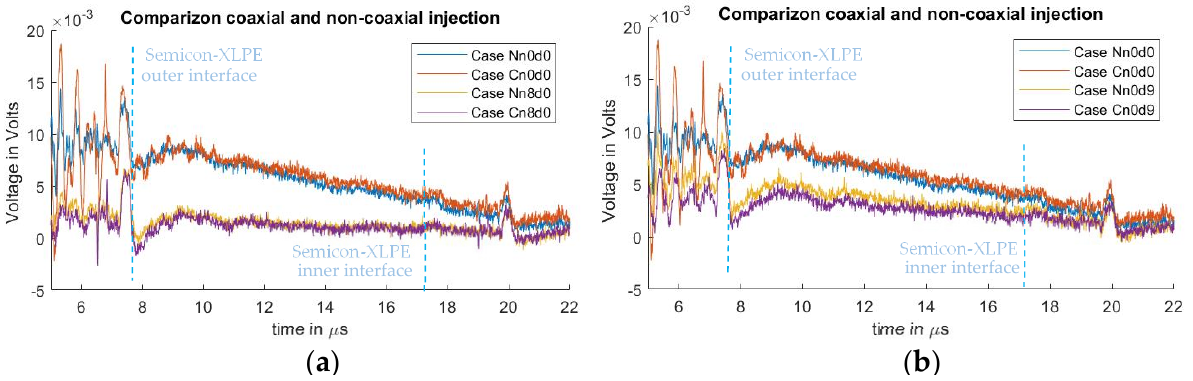
Figure 11. Comparison of acoustic signal distortion utilizing either non-coaxial or coaxial injection. ( a ) Comparison between